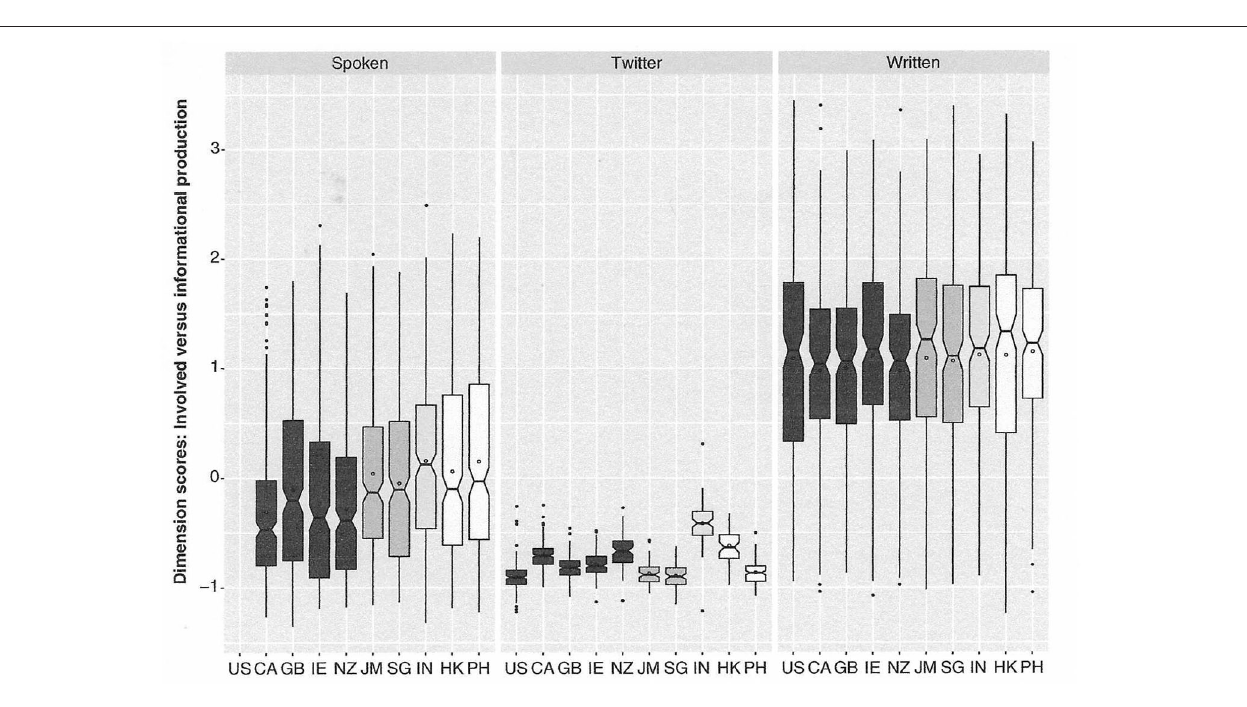
FIGURE 22 | Bohmann’s “Distribution of dimension scores across varieties and modalities; INVOLVED VS. INFORMATIONAL PRODUCTION” (from Bohmann, 2020, p.